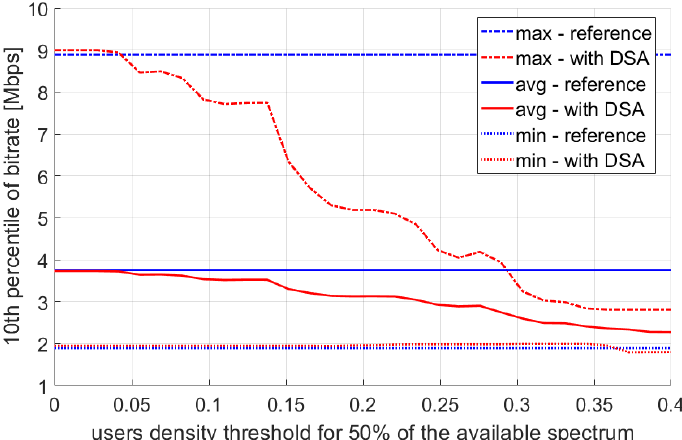
Figure 9. Multiple simulation repetition results—10th percentile of user